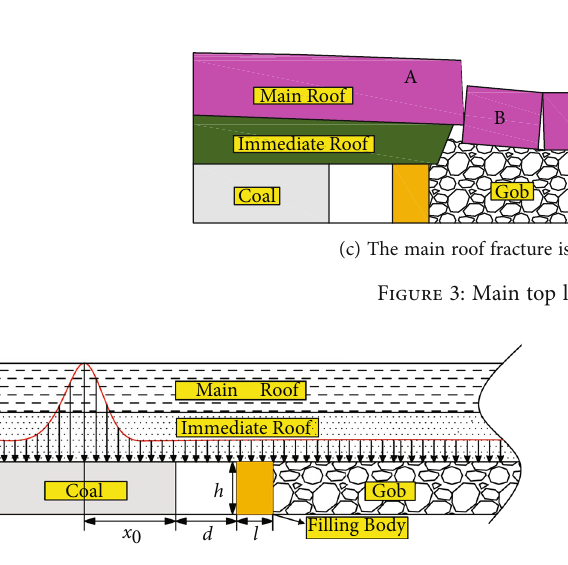
Figure 4: Mechanical model of bearing structure of gob-side entry